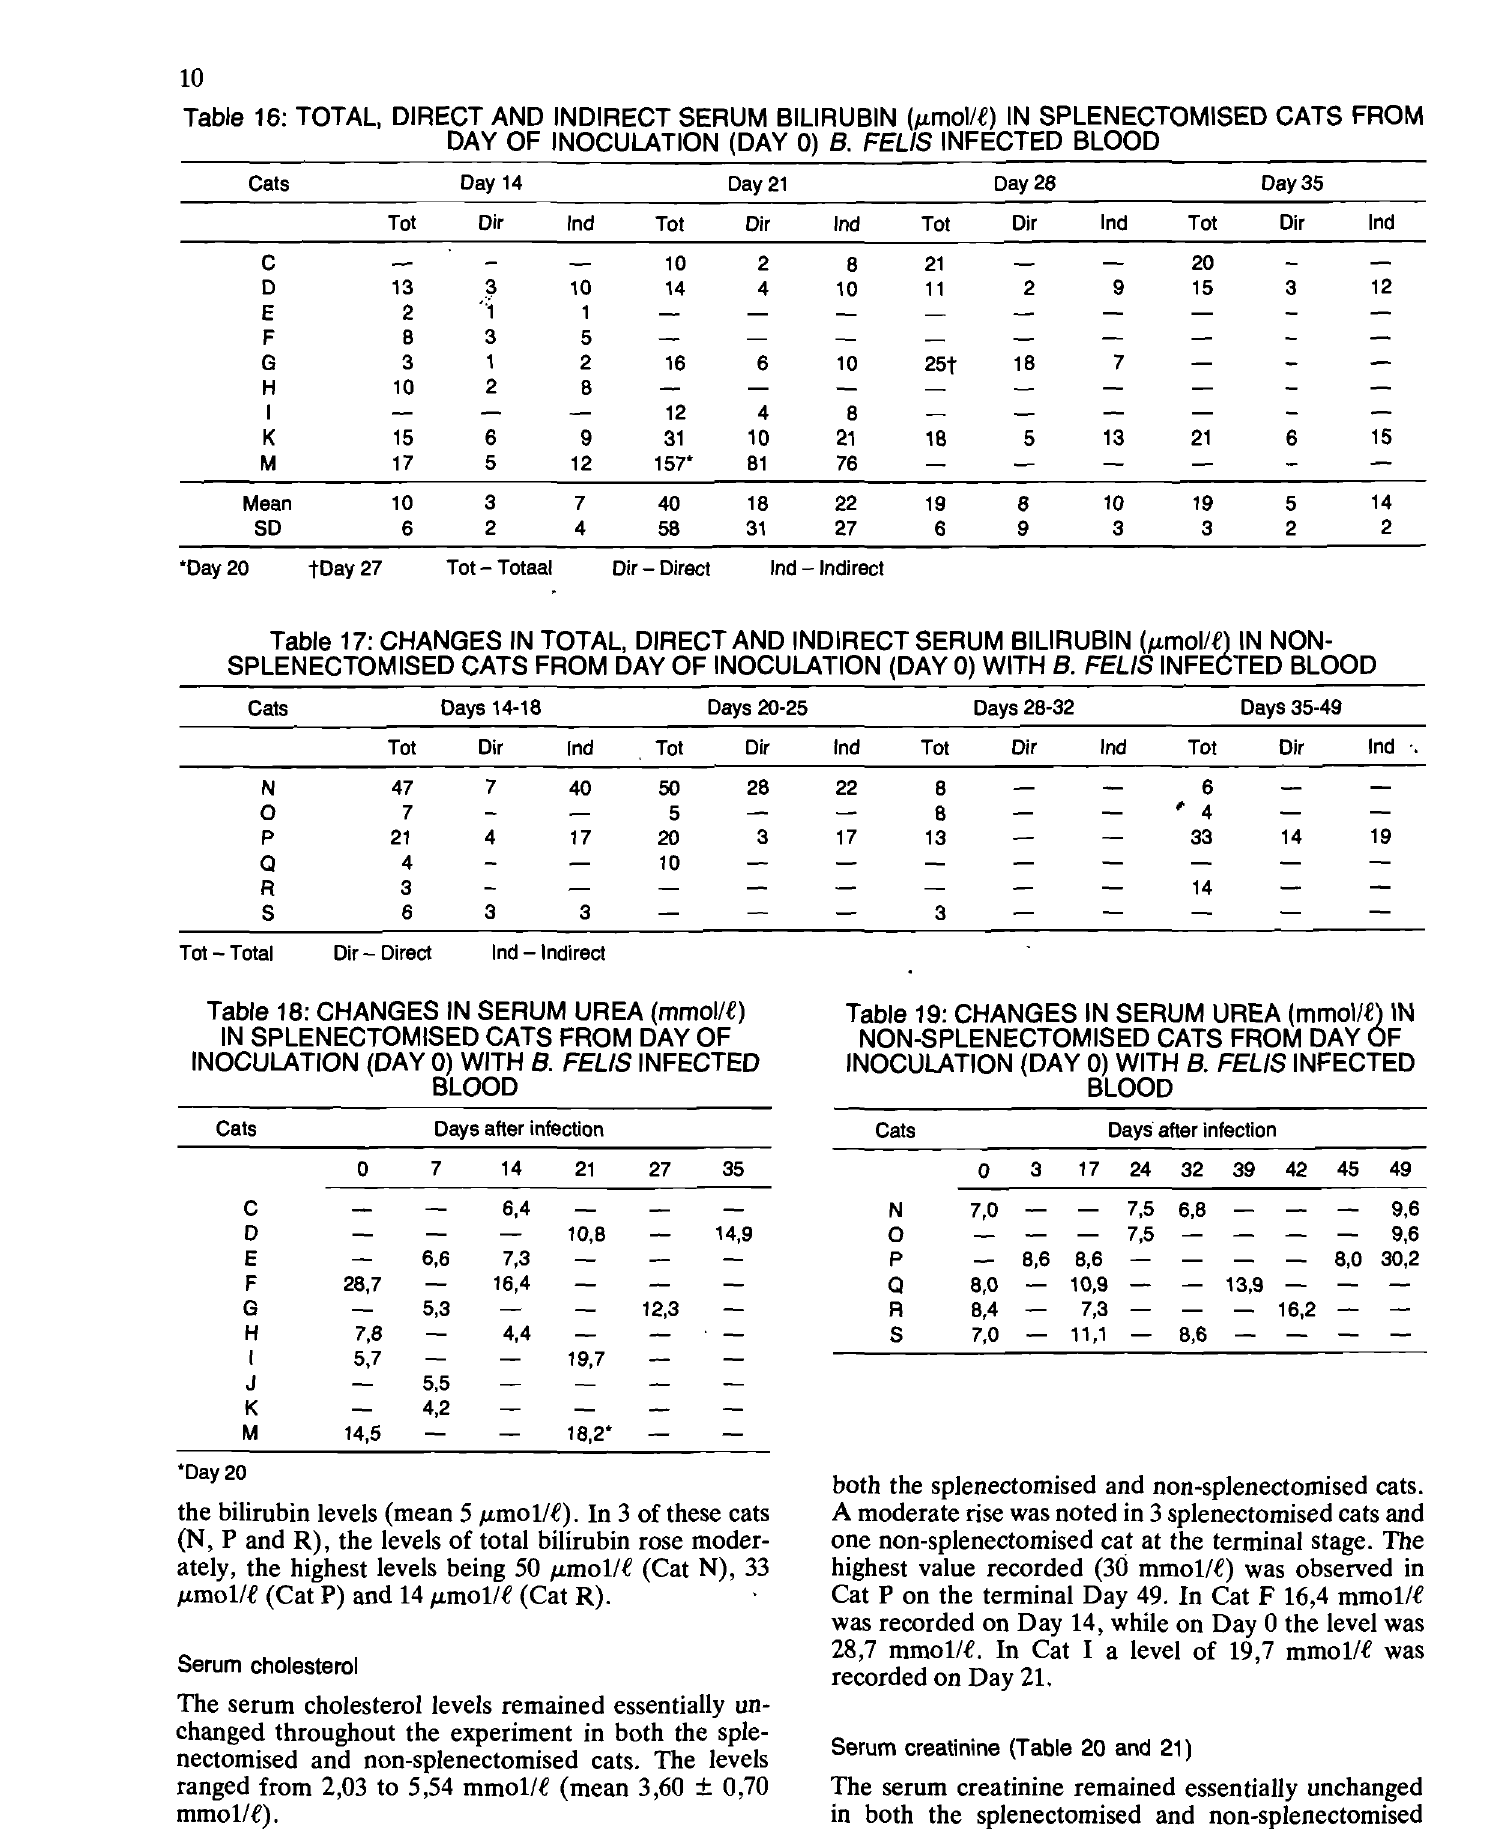
Table 17: CHANGES IN TOTAL, DIRECT AND INDIRECT SERUM BILIRUBIN (J.Lmol/e) IN NON